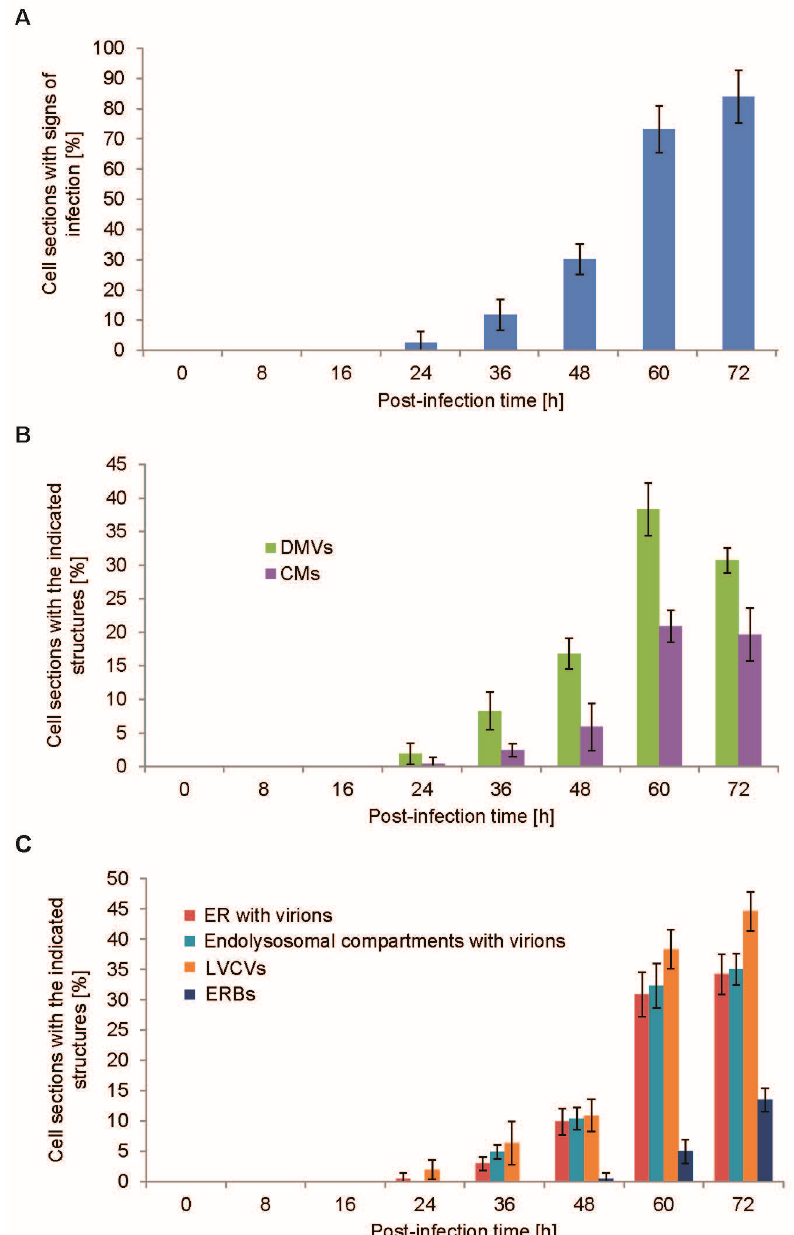
Figure 3. Quantitative analysis of the PEDV-induced structures over the course of the infection. ( A ) The EM preparations described in Figure 1 were used to count the number of cell sections containing at least one of the six PEDV-induced structures (Figure 1) to morphologically assess the proportion of infected cells; ( B ) the percentage of cells displaying DMVs and CMs was determined in the experiments shown in Figure 1; ( C ) the percentage of structures containing viral particles (i.e., virion-positive ER, virion-positive endolysosomal compartments, LVCVs, and ERBs) in the samples shown in Figure 1 was statistically evaluated. Error bars represent the standard deviation from four grids.